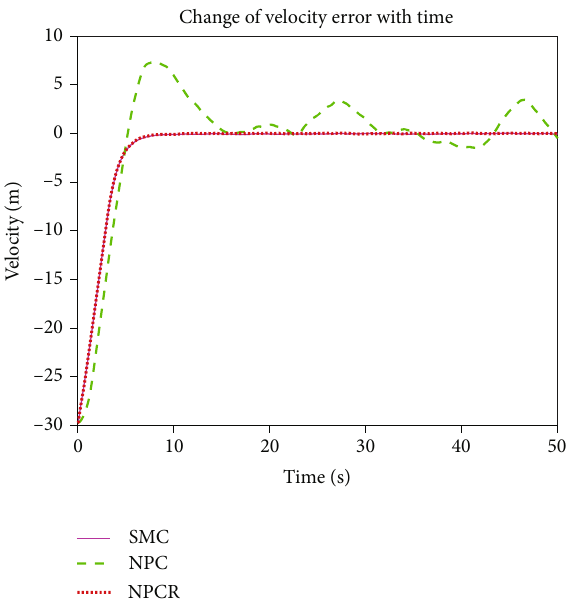
Figure 10: Velocity error changes with time under di ff erent controllers.